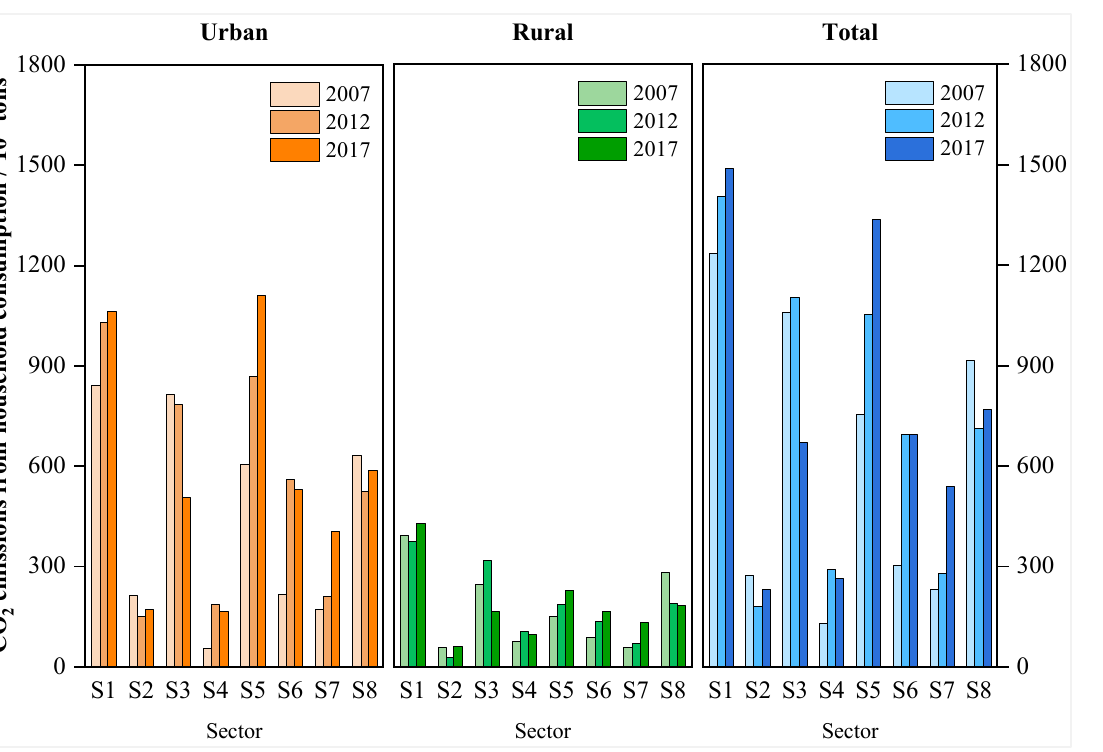
Figure 9. Structure of indirect CO 2 emissions from household consumption in Fujian province. Note: S1 is the food sector; S2 is the clothing sector; S3 is the housing sector; S4 is the household equipment and supplies sector; S5 is the transportation and communication sector; S6 is the education and entertainment sector; S7 is the medical care sector; S8 is other goods and services sector.